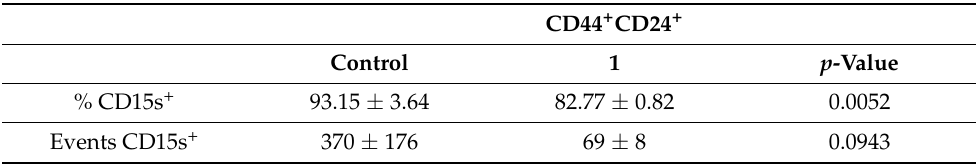
Figure 5. Expression of CD15s in CD44 + CD24 + subpopulation after treatment with compound 1 . Notes: R264- CD15 + CD44 − cells; R265- CD15s + CD44 + cells; R266- CD15s − CD44 + cells; R267- CD15s − CD44 − . Table 3. Percentage and events of CD15s in CD44 + CD24 + subpopulation after treatment with compound 1 .